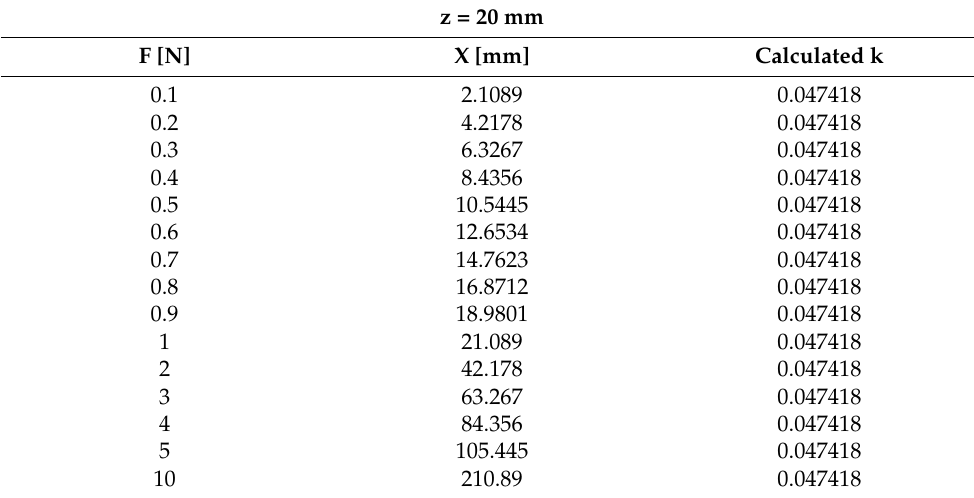
Table 3. Simulation values for z = 20 mm and force F from 0.1 to 10 N.